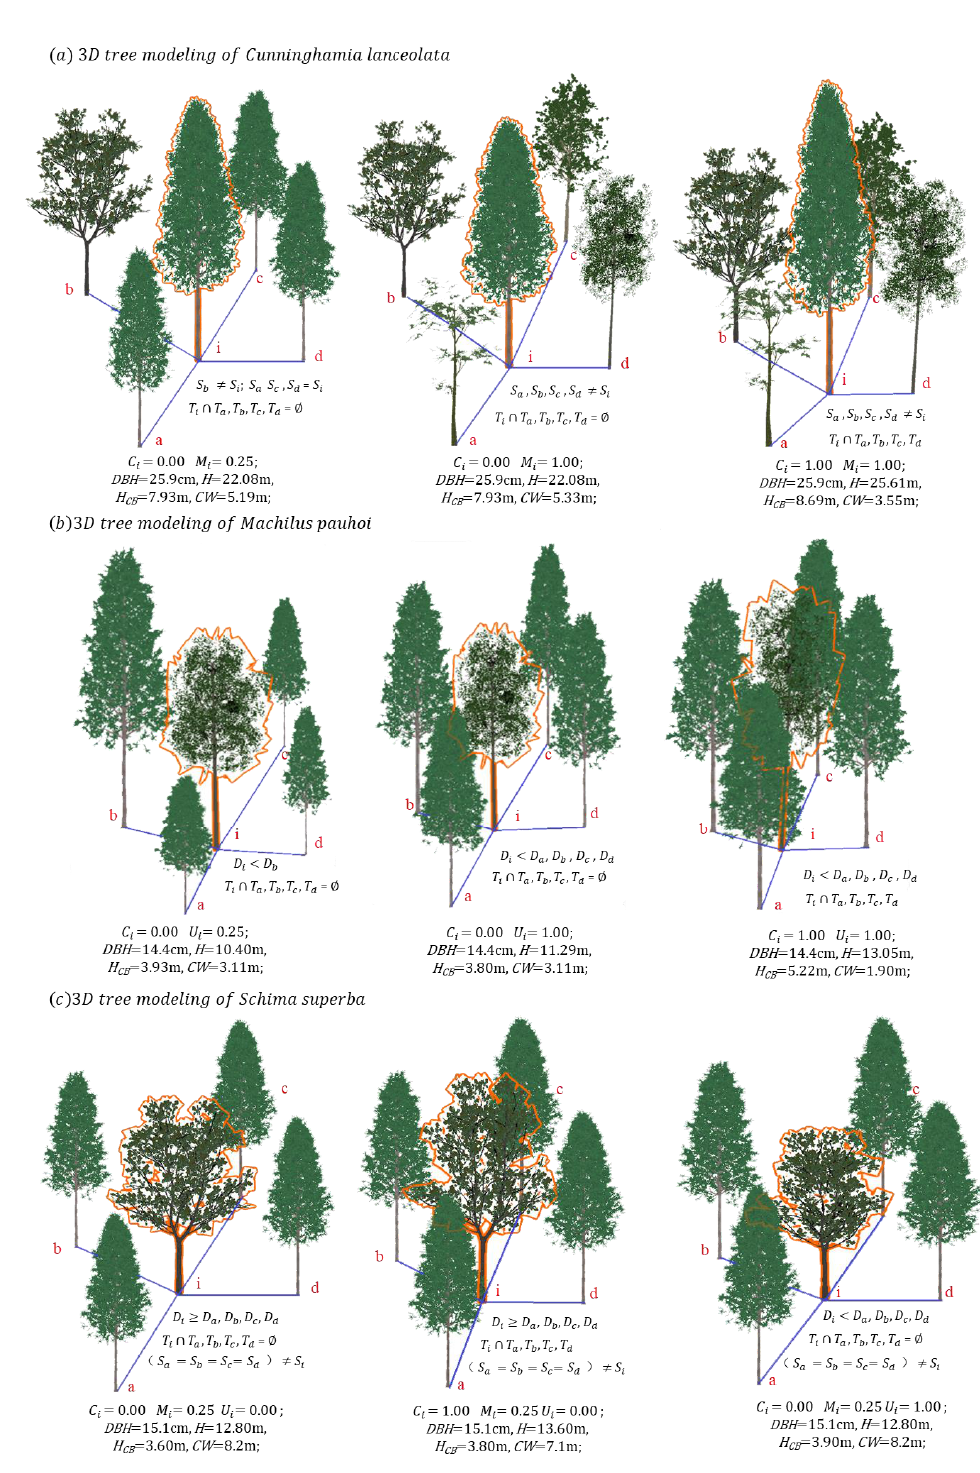
Figure 7. Three-dimensional modeling of Cunninghamia lanceolata , Machilus pauhoi , and Schima superba under different C i , U i , and M i . The values of C i , U i , and M i were 0.00, 0.25, 0.50, 0.75, and 1.00, respectively. Cunninghamia lanceolata , Machilus pauhoi, and Schima superba are represented by SM, BHN, and MH, respectively. Since Cunninghamia lanceolata (DBH = 25.9 cm), Machilus pauhoi (DBH = 14.4 cm), and Schima superba (DBH = 15.1 cm) occurred the most frequently in the study region, we chose them as our examples.